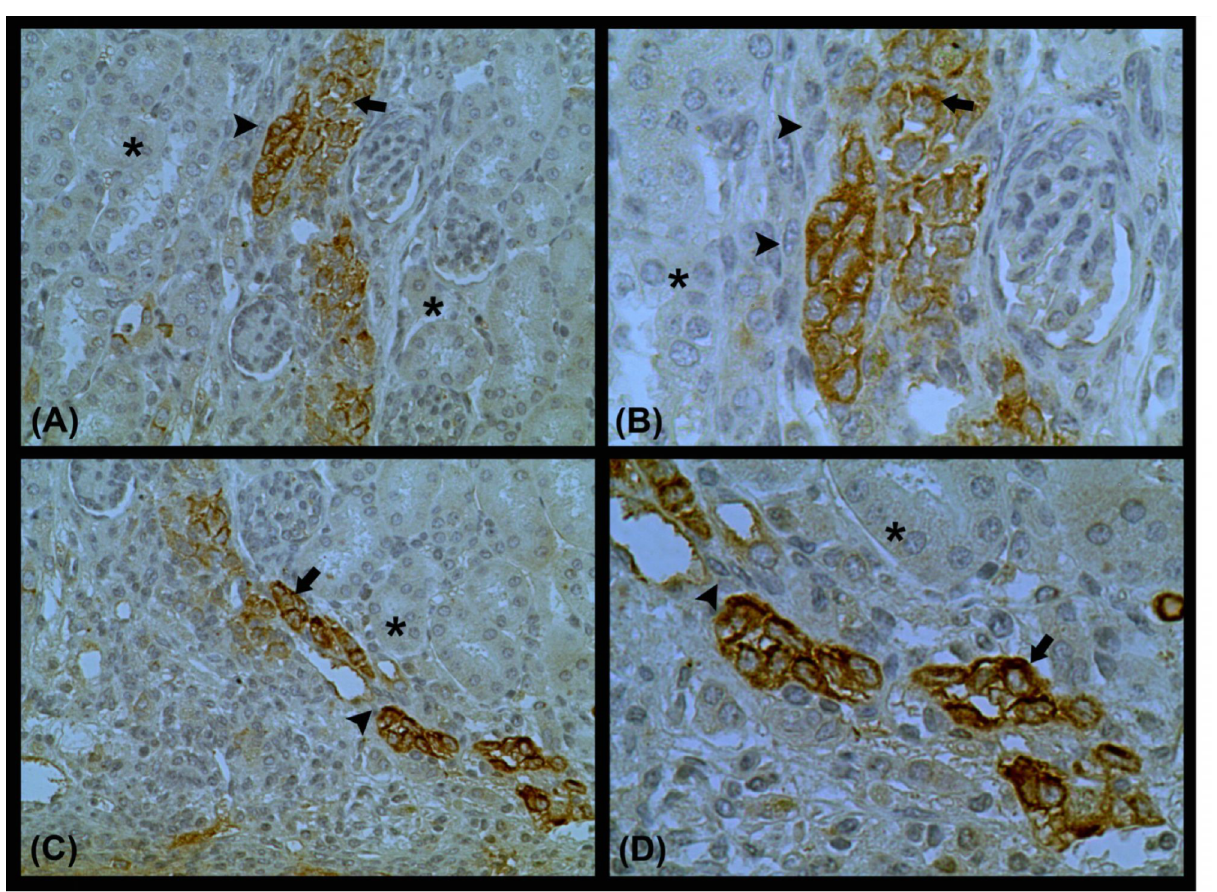
Fig 9. Immunohistochemistry for IDO expression in renal tissue 28 days after T24 cell inoculation. IDO-positive cells were found in the infiltrate center (arrow), while IDO-negative cells were predominantly found in the periphery of the infiltrate (arrowhead). IDO immunostaining was not observed in the renal parenchyma